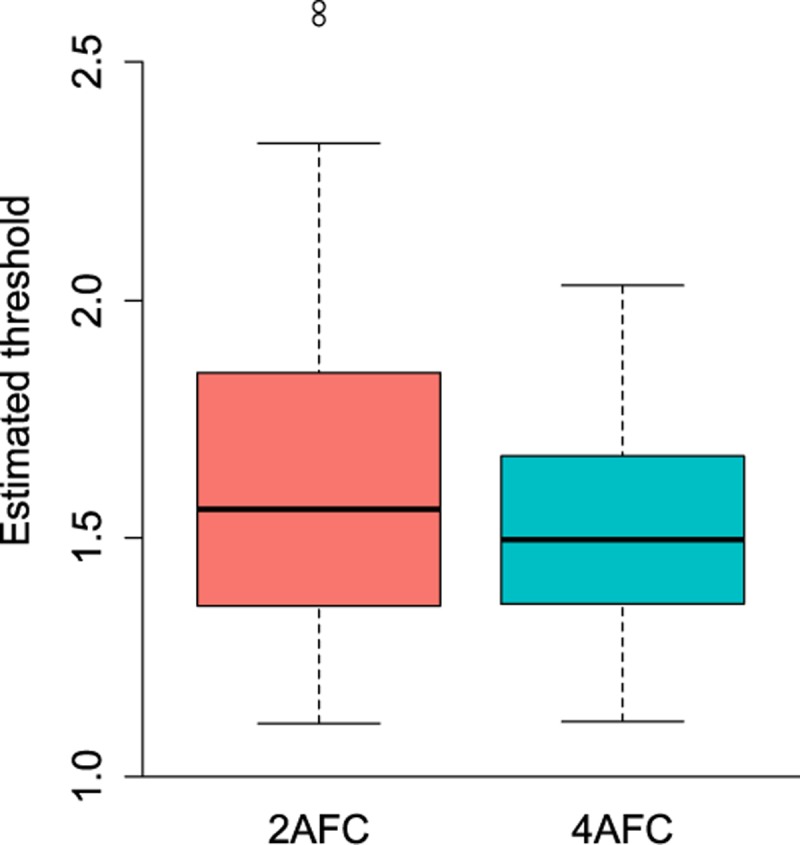
Boxplot of stereothresholds (log10 arcsec) in 2-AFC and 4-AFC task (thresholds below 500 arcsec only).